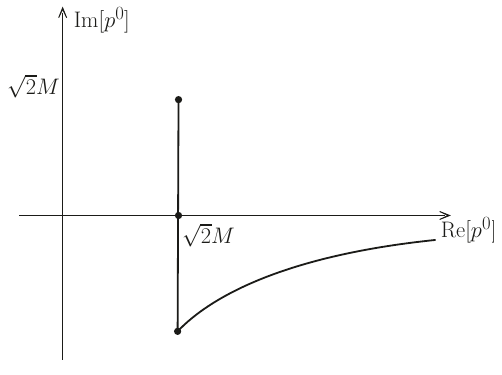
Figure 9 . Analytic deformation of the branch